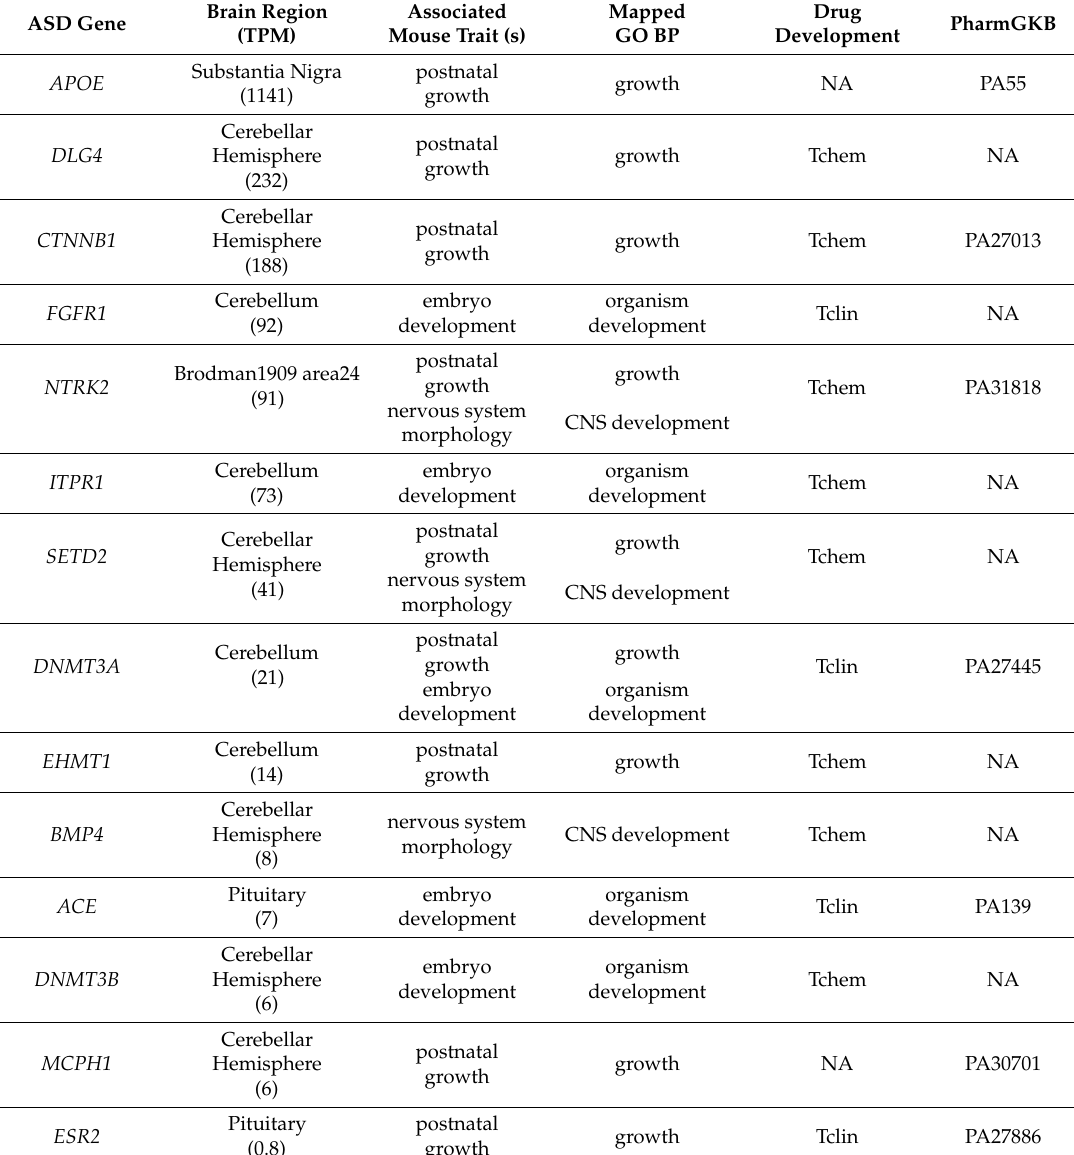
Table 3. Prioritized Genes with Pathogenic / Likely Pathogenic